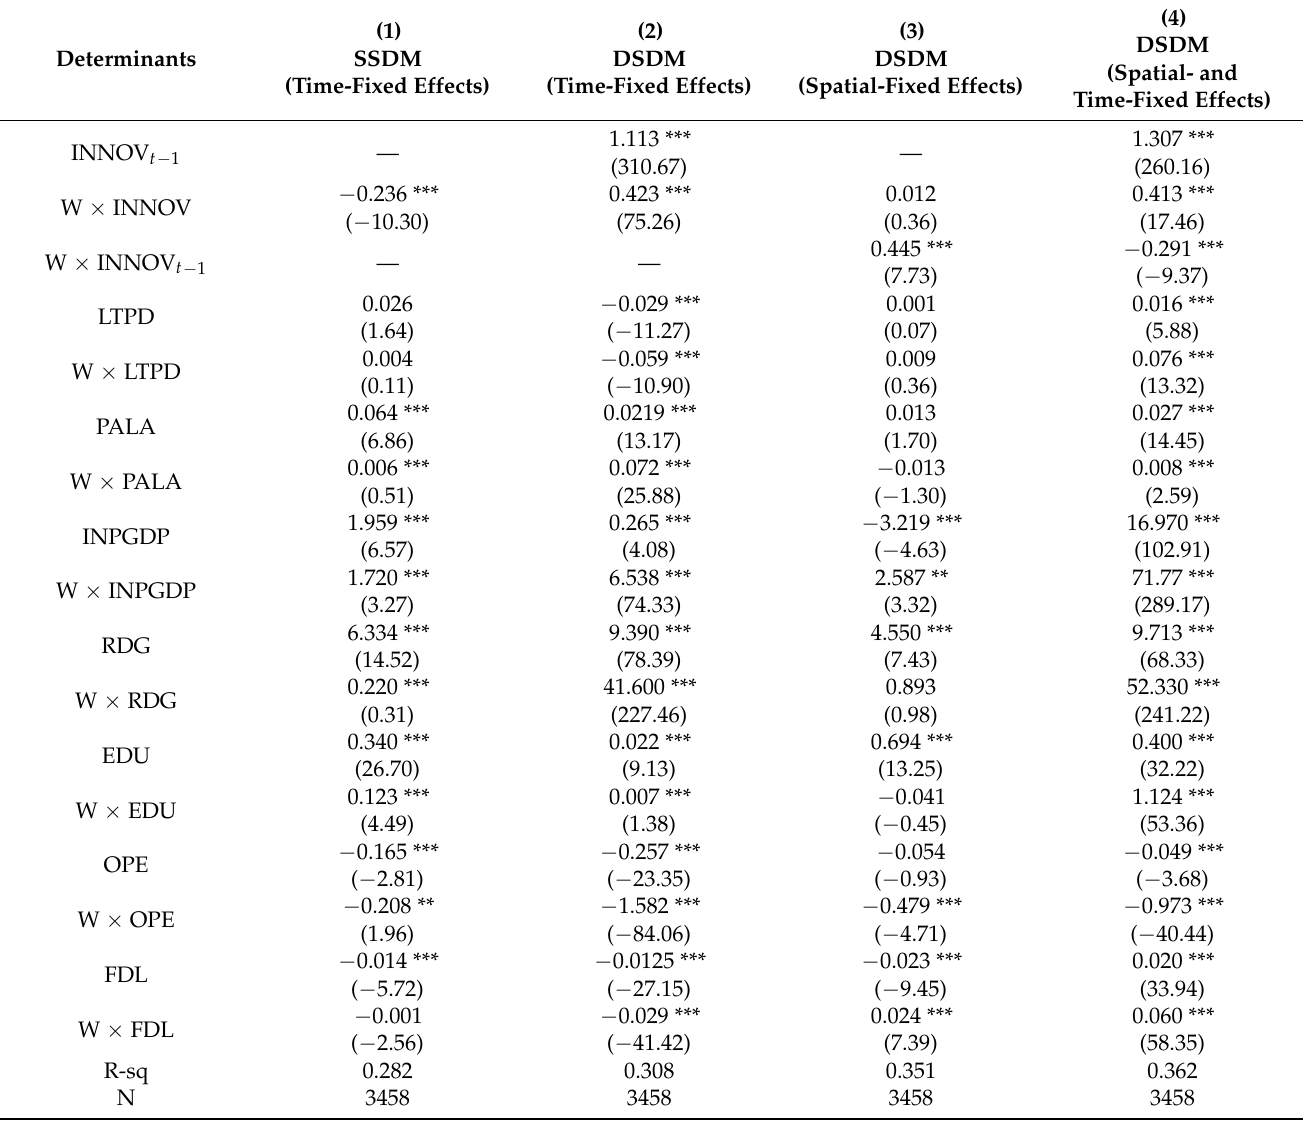
Table 4. Estimated regression results of the